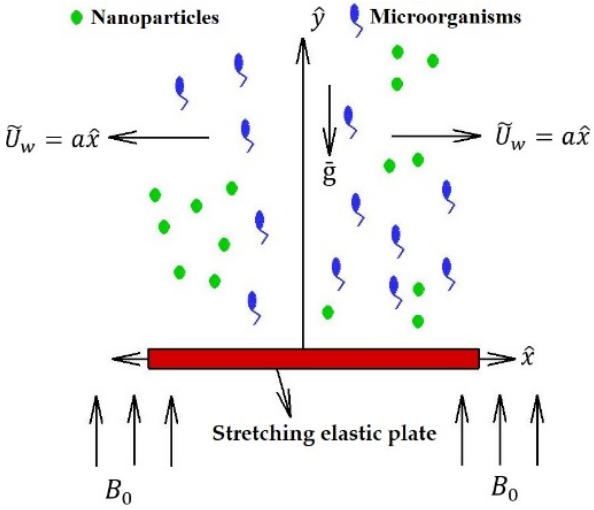
Figure 1. Geometry for the flow problem.